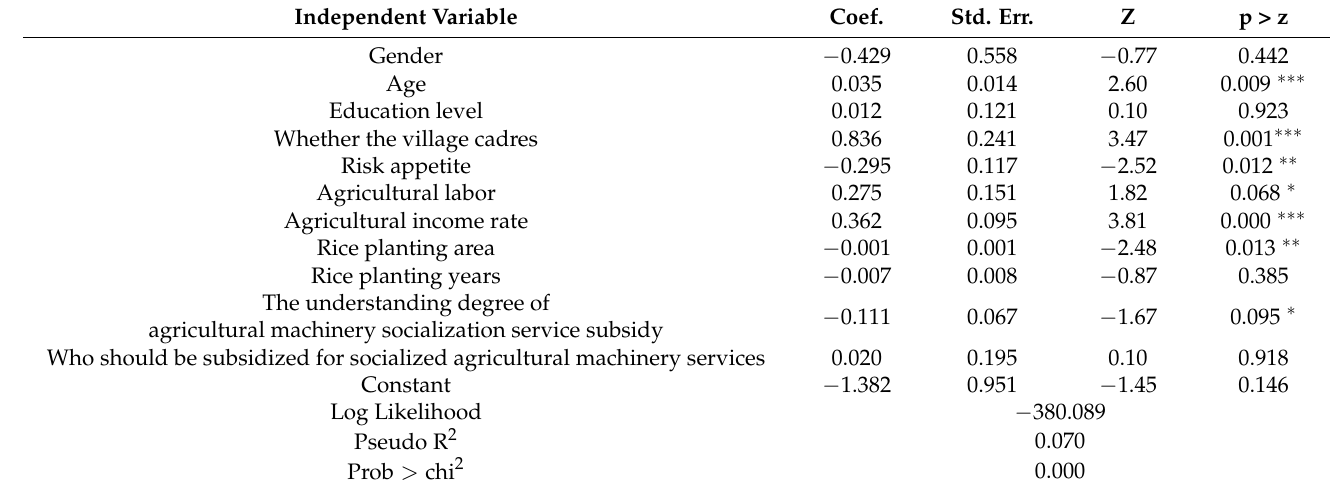
Table 2. Results of the regression model.